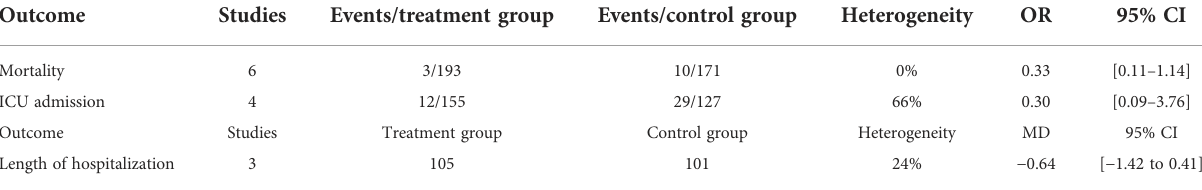
TABLE 2 Outcomes in trials administrating vitamin D